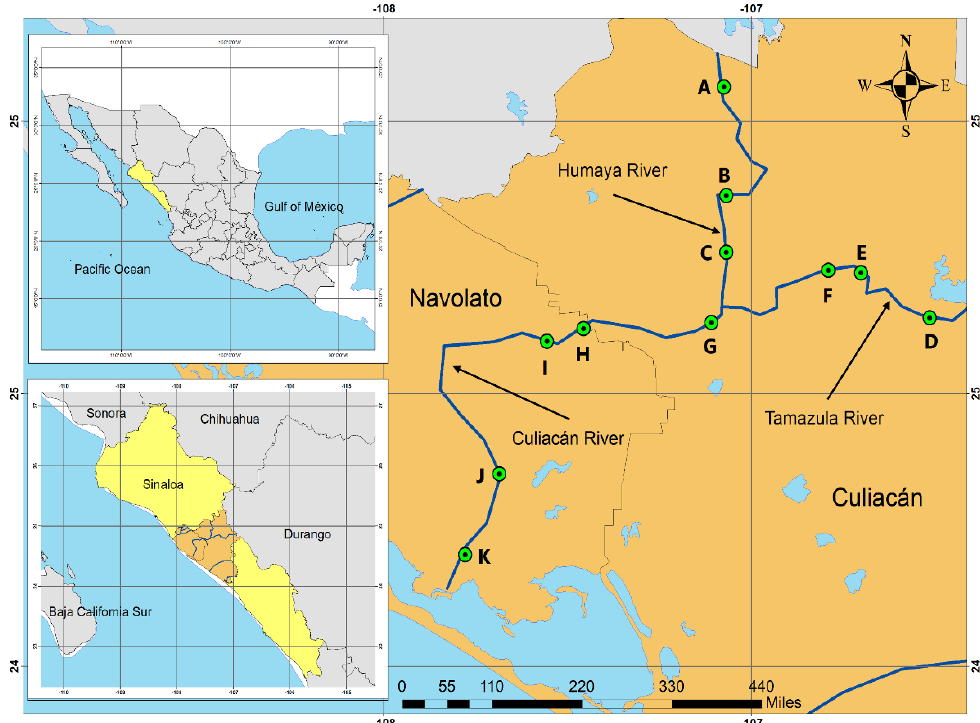
Figure 1. Schematic diagram of the sampling sites in the Culiacan Valley in northwestern Mexico. Sampling sites A, B, and C were located along the Humaya River, and sampling sites D, E, and F were located along the Tamazula River. Site G is located at the point of convergence for both rivers and along with sites H, I, J and K, they belong to the Culiacan River. Table 1. Latitude and longitude coordinates of each sampling site for the recovery of water from the Humaya River, Tamazula River, and Culiacan River in northwestern Mexico.